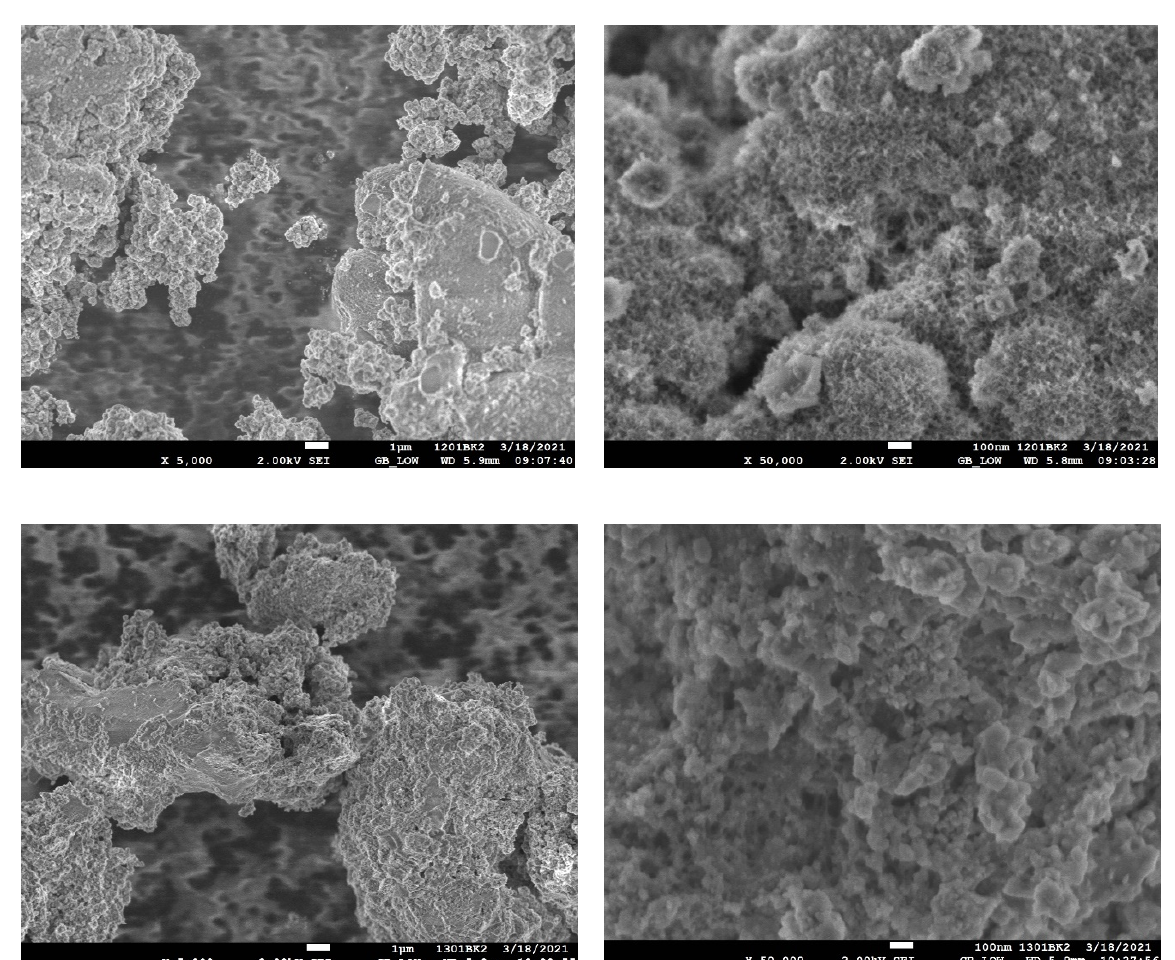
Figure 14. SEM images of the insoluble part after the treatment of 5 mM BRX solution in 20 mM aqueous NaOH with NaBH 4 /CuSO 4 (top left 5000 times magnification, top right 50,000 times magnification) and with CuSO 4 /NH 4 OH/glucose/NaBH 4 (bottom left 5000 times magnification, bottom right 50,000 times magnification).